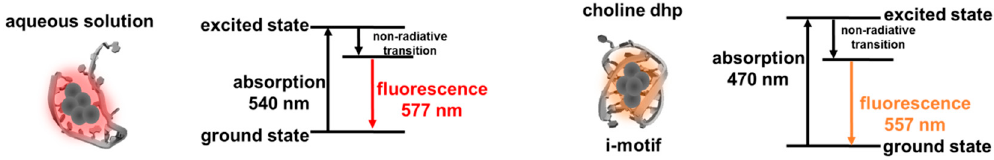
Figure 5. The possible folding of C12-templated Ag nanoclusters (NCs) in an aqueous solution and in choline dihydrogen phosphate (dhp).